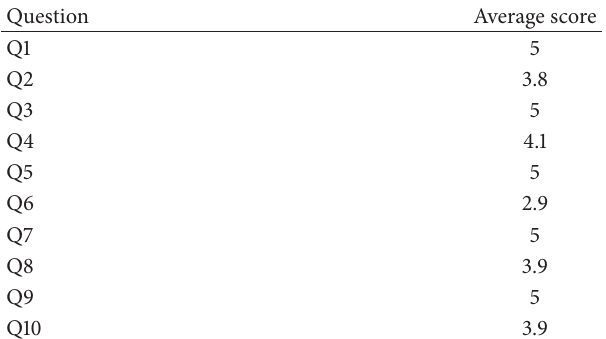
Table 6: Average score for user experience evaluated as Completely Disagree: 1, Disagree: 2, Neutral: 3, Agree: 4, and Completely